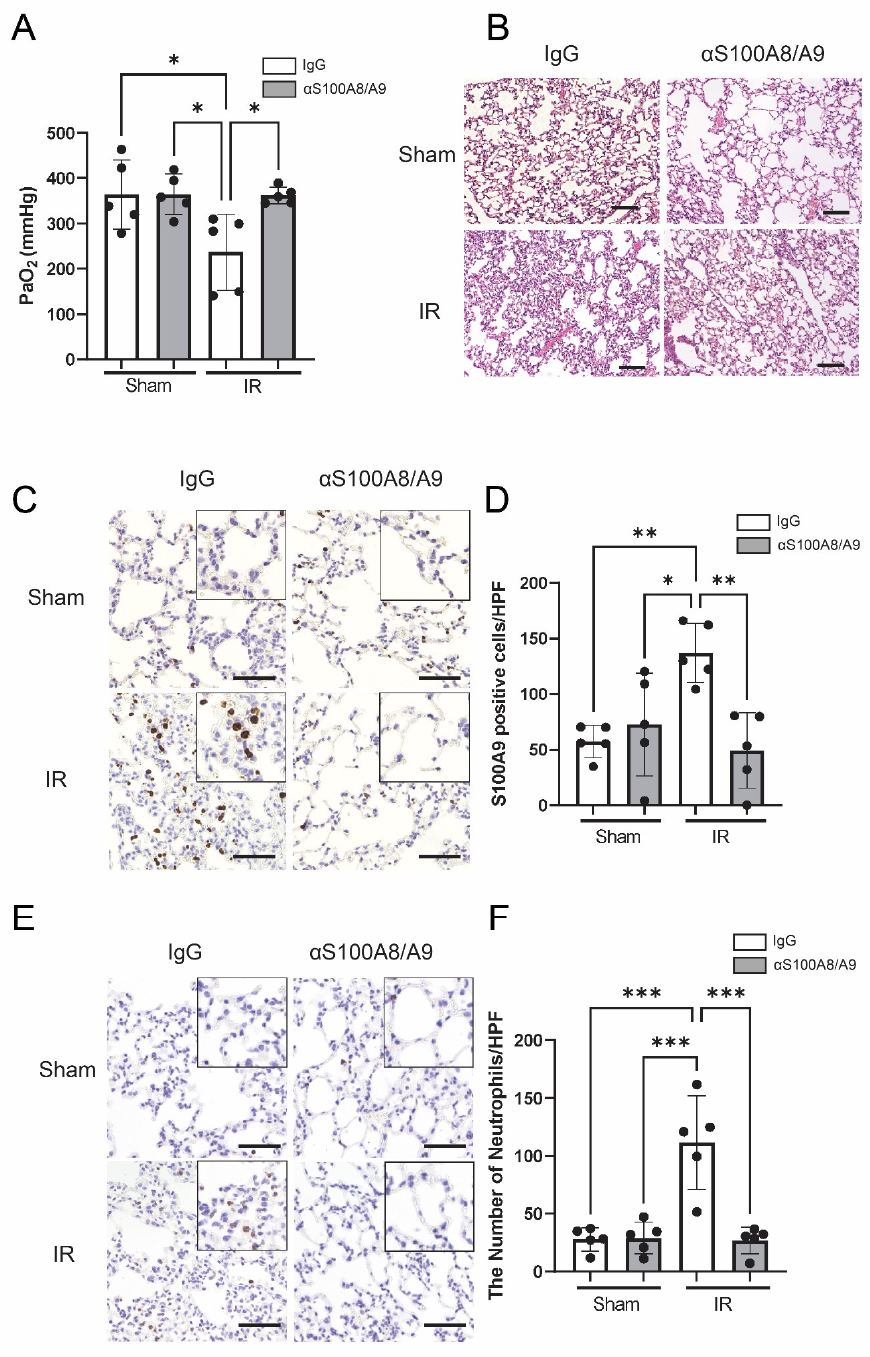
Figure 5. Oxygenation and pathogenesis show the therapeutic effect of anti-S100A8/A9 mAb on